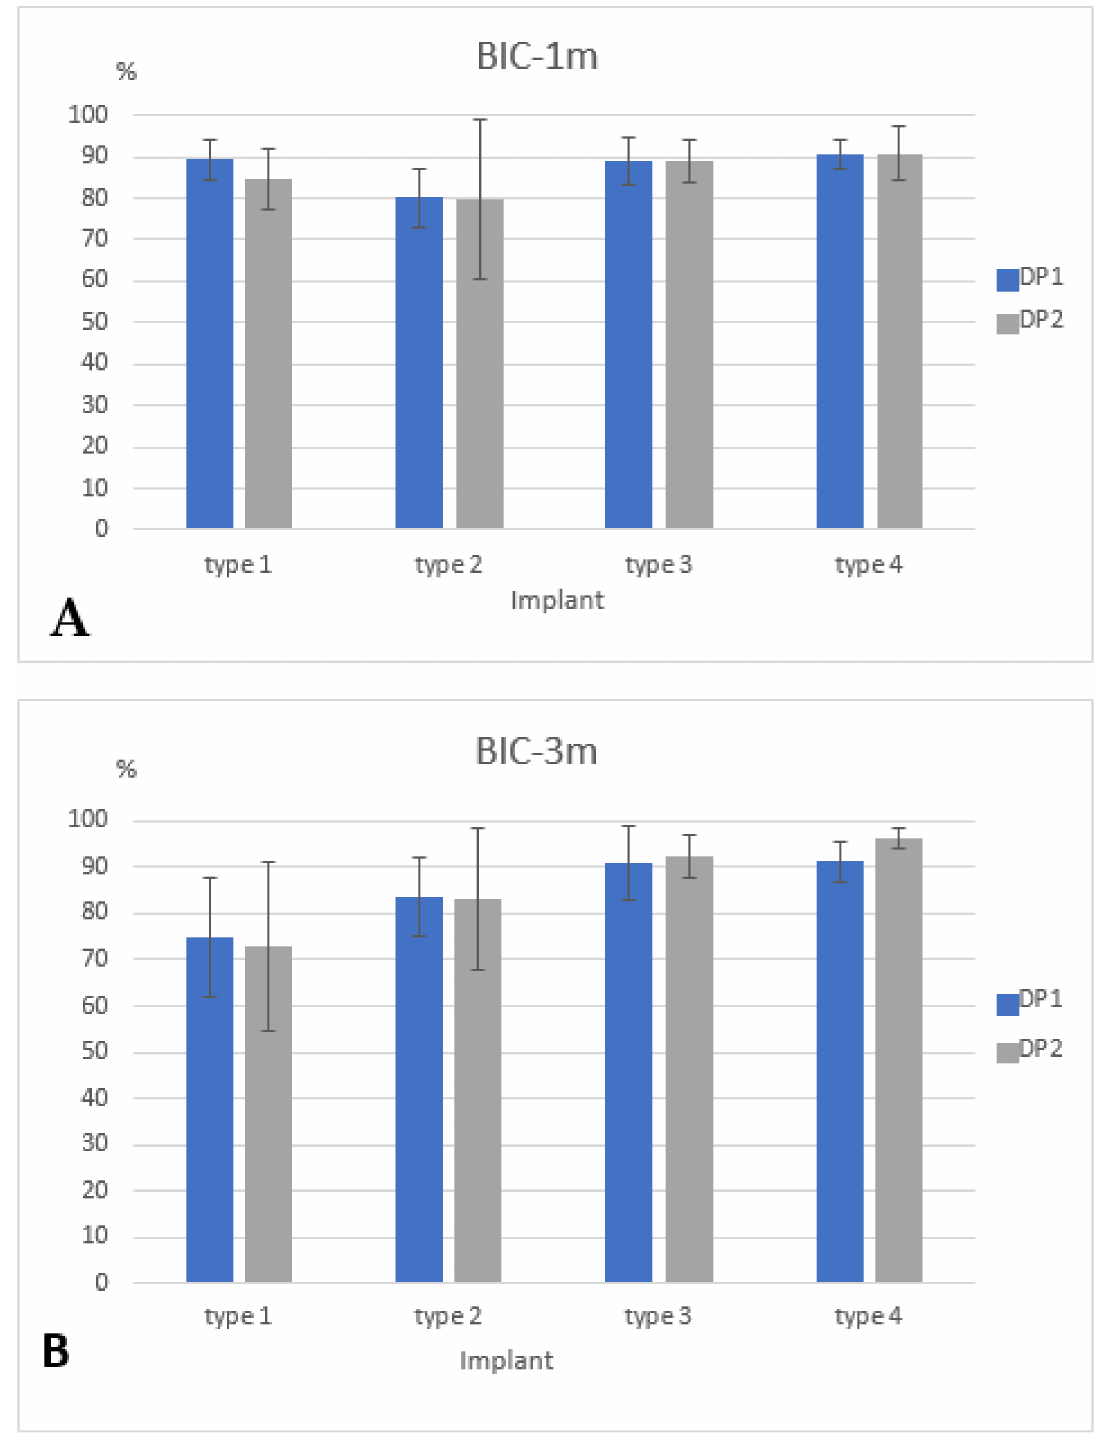
Figure 5. ( A )—Total bone-to-implant contact one month after (t-BIC-1 m) implants were inserted with the standard underdrilling protocol (DP1) and the extra underdrilling protocol (DP2). ( B )—Total bone-to-implant contact three months after (t-BIC-3 m) implants were inserted with the standard underdrilling protocol (DP2) and the extra underdrilling protocol (DP1). Data are presented as the average ±